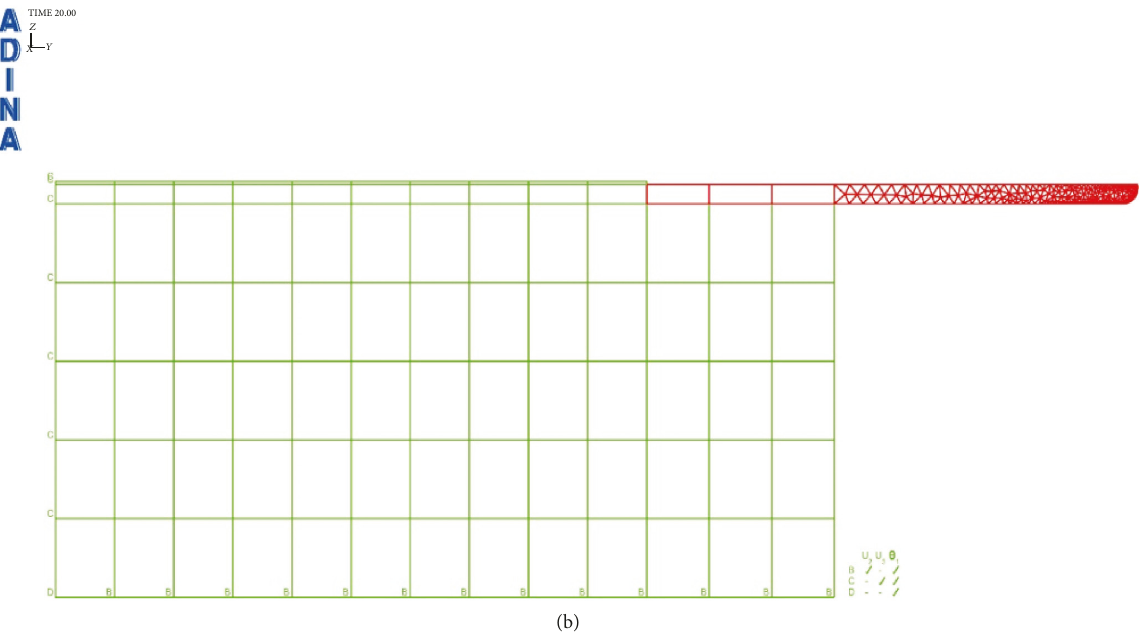
Figure 2: Plane finite element model of the pipe joint. (a) Rigid point method. (b) FE mesh for socket.